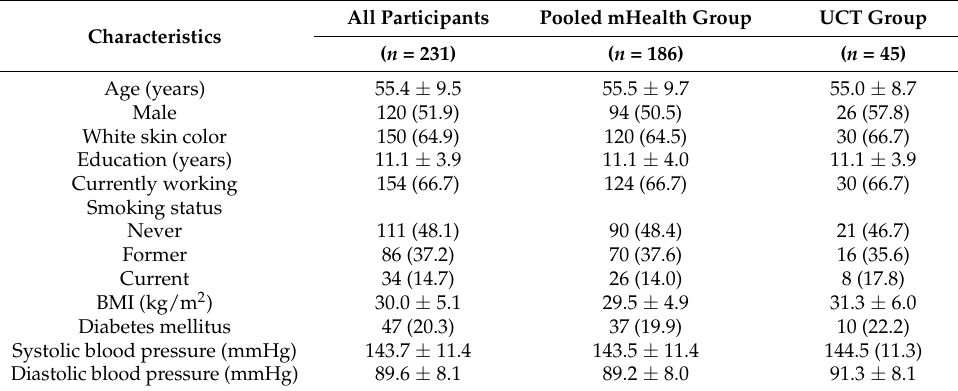
Table 1. Baseline characteristics, mean ± SD or n